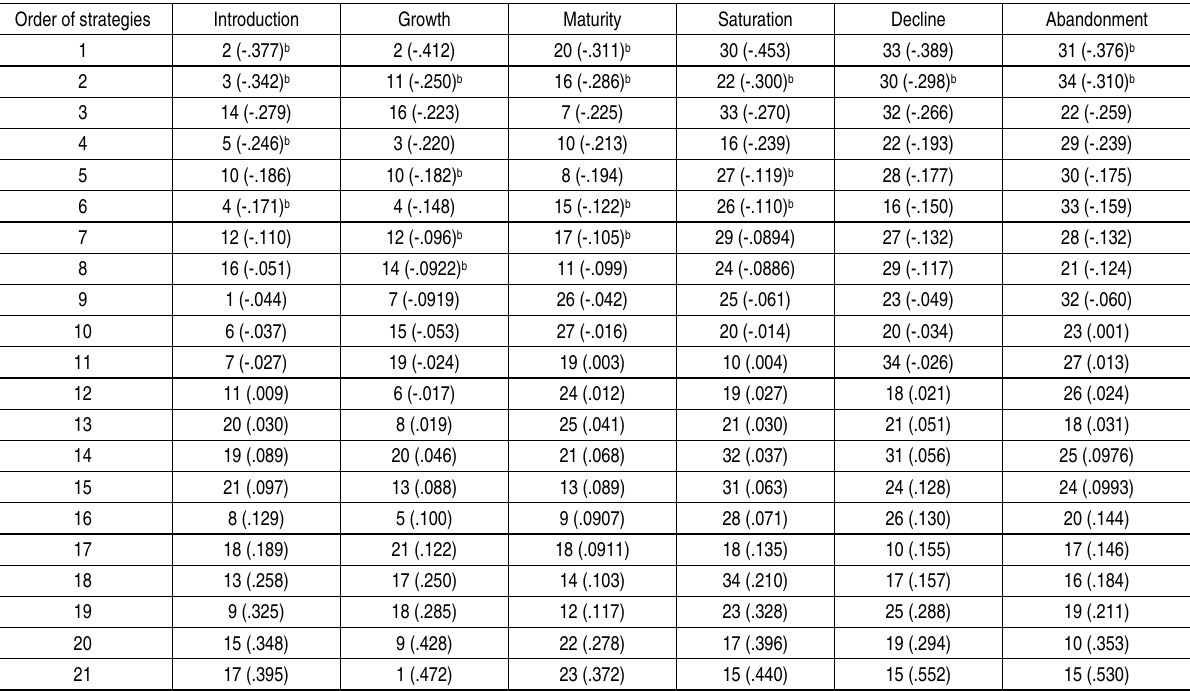
Table 6. Ranking of procurement strategies by Guttman scores a by product life cycle stage Order of strategies